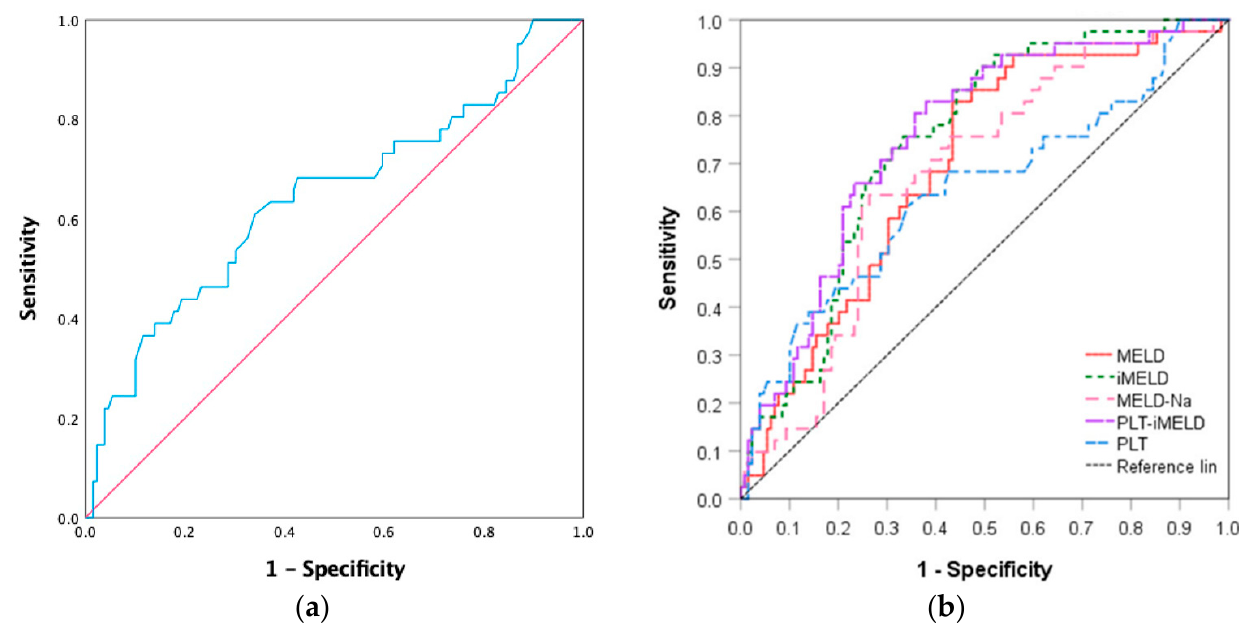
Figure 1. Efficacy of receiver operating characteristic curves (ROC) in predicting the outcome. ( a ) ROC curve for PLT counts. ( b ) ROC curve for the prognostic model. PLT: platelet; MELD: model for end-stage liver disease; MELD-Na: MELD-sodium; iMELD: integrated MELD; PLT-iMELD: platelet-integrated MELD. Table 4. AUC and cut-off values of the prognostic